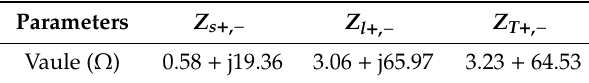
Table A2. Parameters of the simulation